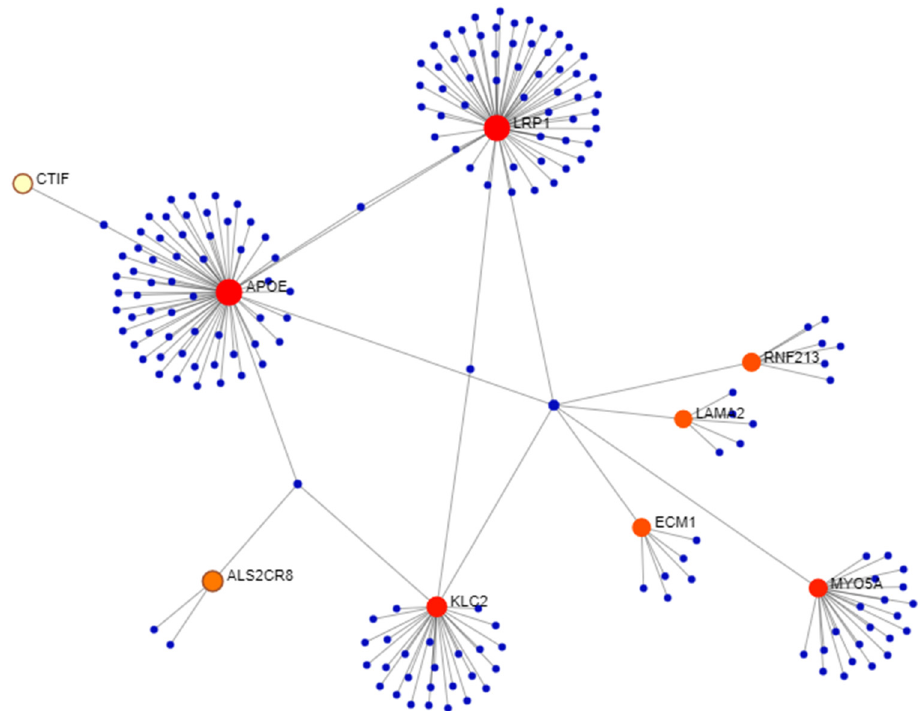
Figure 1. Subnetwork connecting genes with rare variants identified in pediatric patients with peripheral vestibular dysfunction. Red and yellow nodes indicate input genes (Table 2). CARF is included in the subnetwork though not labelled in the figure. Table 3. Top pathways per database from network analysis of candidate genes identified for pediatric vestibular disorders.